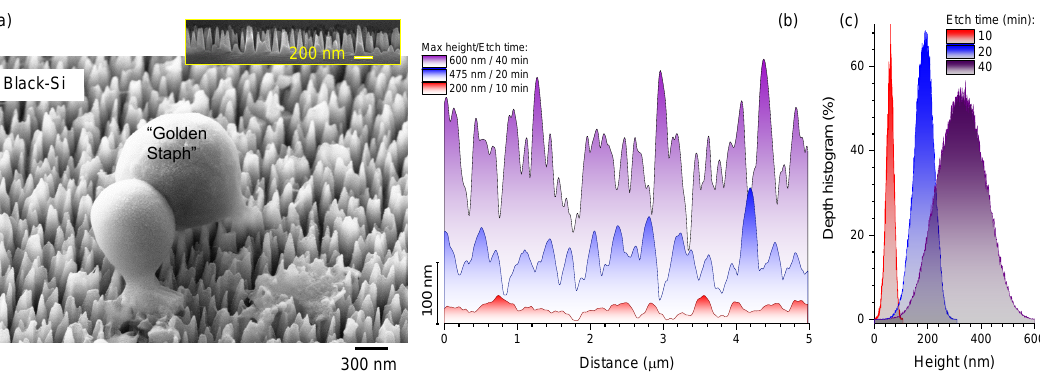
Figure 1. Mechanically bactericidal surface of b-Si. ( a ) Scanning electron microscope (SEM) image of a Gram-positive Staphylococcus aureus “Golden Staph” cell ruptured on b-Si. Inset SEM image shows